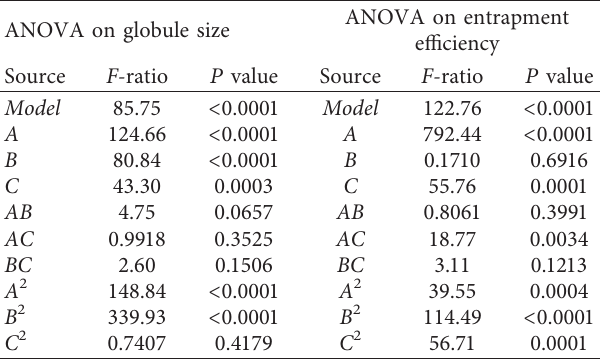
Table 2: Analysis of variance data for globule size and entrapment